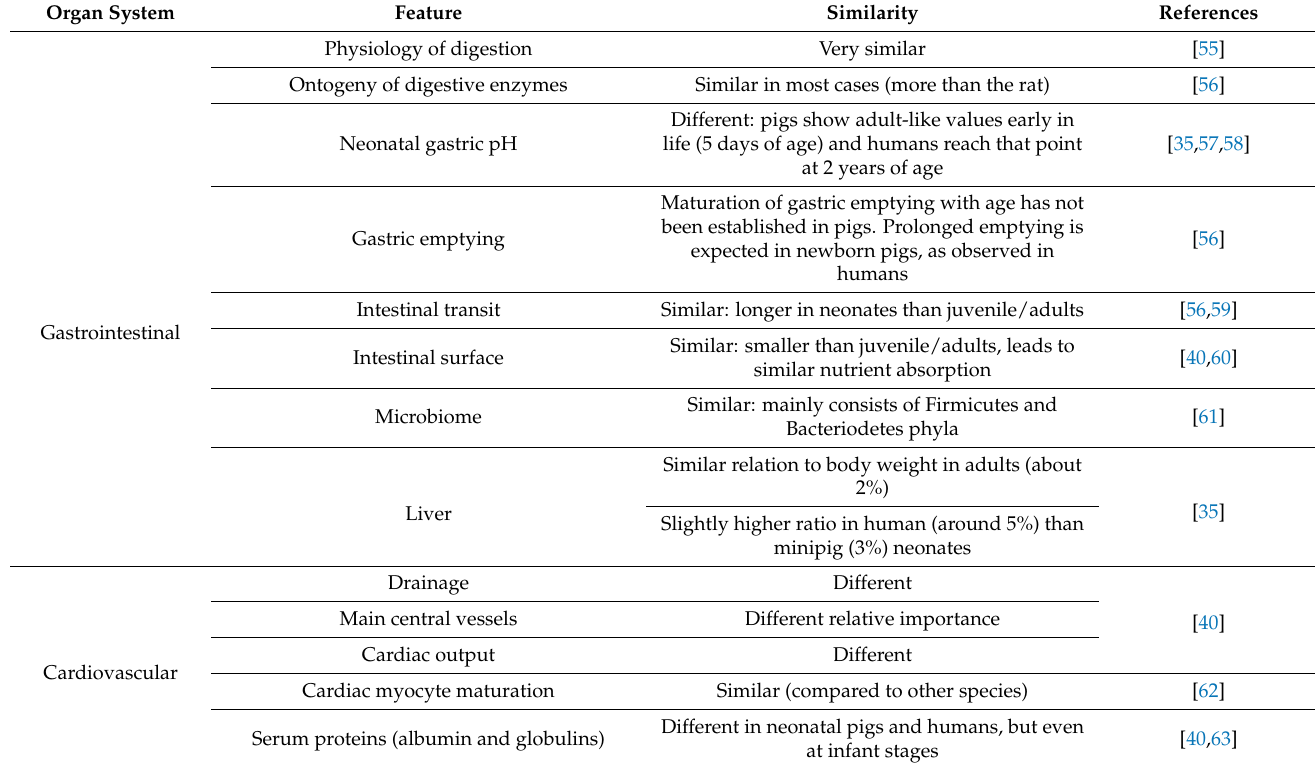
Table 1. Summary of main similarities and differences in maturation of different organ systems in pigs and humans. Organ